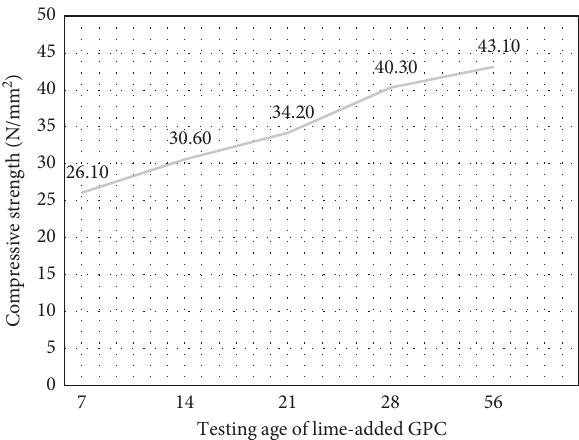
4: Effect of temperature on lime-based